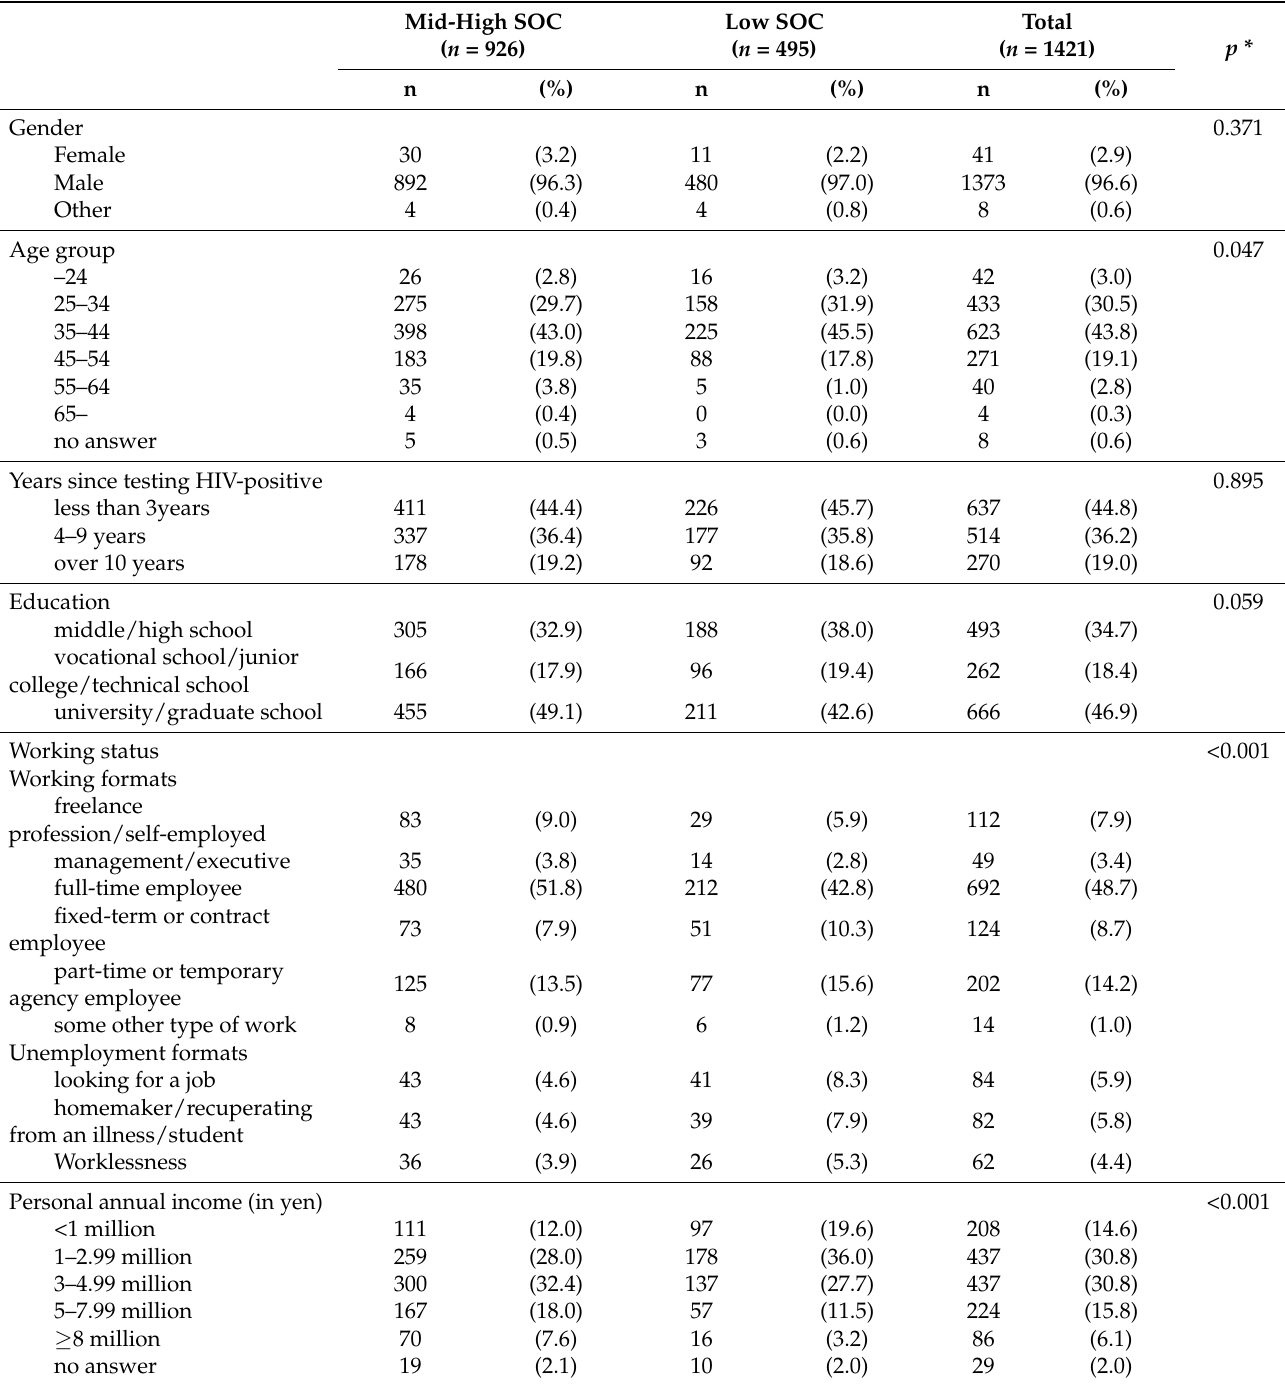
Table 2. Sample statistics of demographic variables and socioeconomic status by low and middle to high sense of